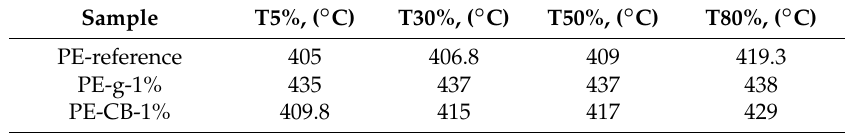
Table 1. TGA data analysis of the neat multimodal-HDPE, PE-CB-1% and